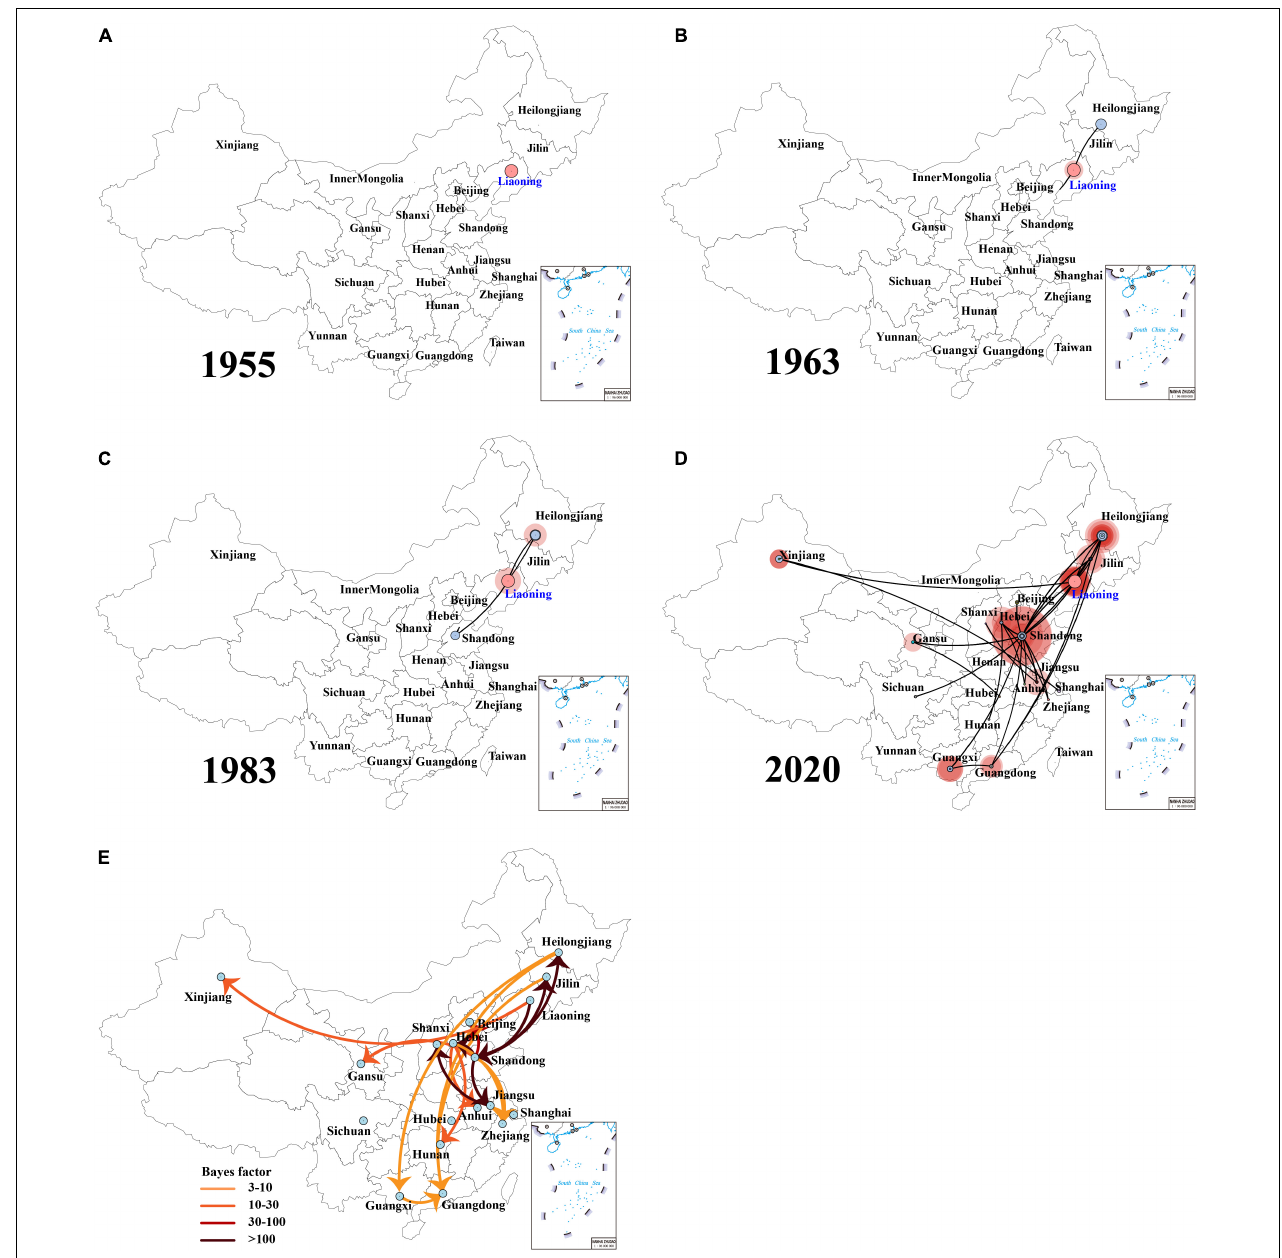
FIGURE 6 | The dynamics analysis of geographical regions of the LX4 genotype isolates from China (A–D) . Spatiotemporal dynamics of the full-length genome gene sequences of LX4 genotype infectious bronchitis virus (IBV) among 18 localities. Bayes factor (BF) test for significant non-zero rates and regional transmission analysis (E) . Curves show the among-province virus lineage transitions statistically supported with Bayes factor > 3 for all the LX4 genotype IBV isolates in